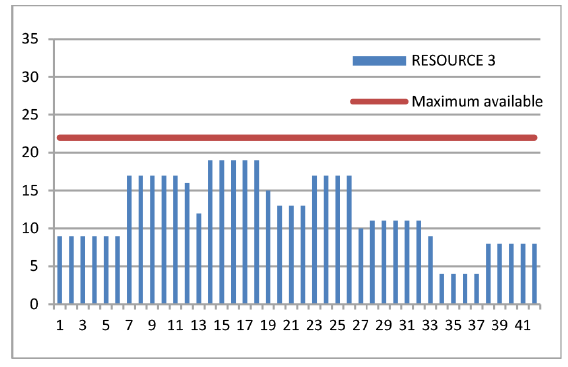
Figure 21. Daily usage of resource 3 throughout the calendar of the project (before using the method)-Experiment